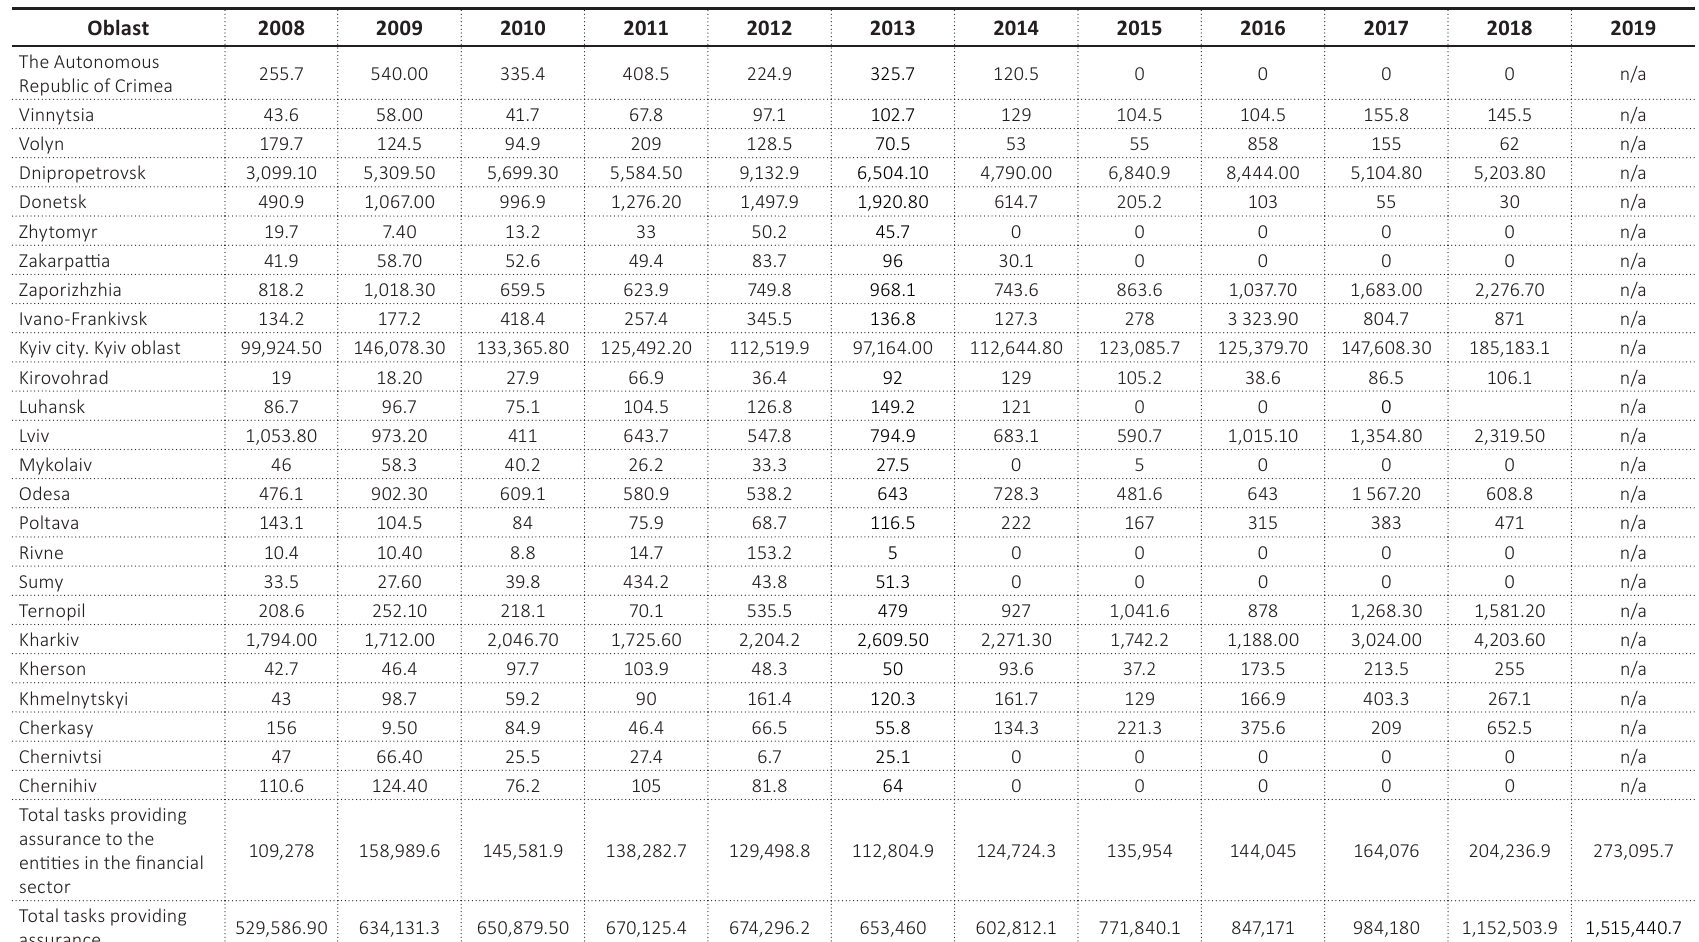
Source: Compiled by the authors according to